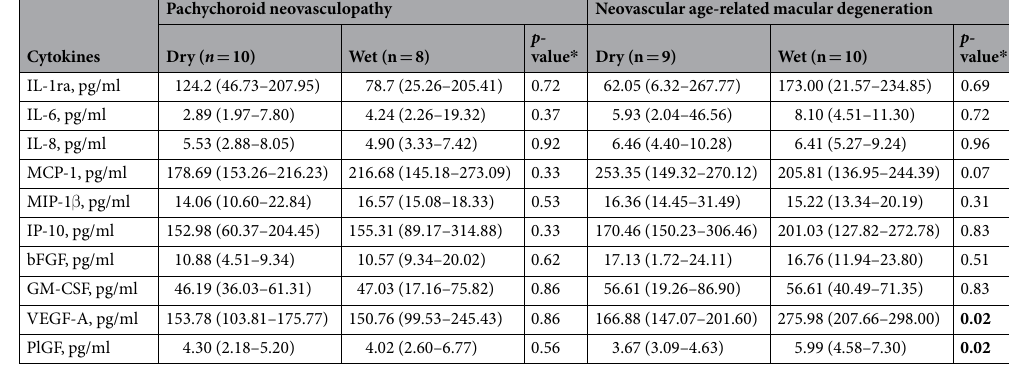
Table 5. Cytokines Associated with dry Maculae after the First Aflibercept Injection in Patients with Pachychoroid Neovasculopathy and Neovascular Age-related Macular Degeneration. Values are the median (interquartile range). P < 0.05 was considered significant (bold). * Wilcoxon signed-rank test. IL- 1ra = Interleukin 1 receptor antagonist; IL = interleukin; MCP-1 = monocyte chemoattractant protein 1; MIP-1 β = macrophage inflammatory protein 1 β ; IP-10 = interferon- γ -induced protein 10; bFGF = basic fibroblast growth factor; GM-CSF = granulocyte macrophage colony-stimulating factor; VEGF-A = vascular endothelial growth factor A; PlGF = placental growth factor. Other cytokines were below the detection